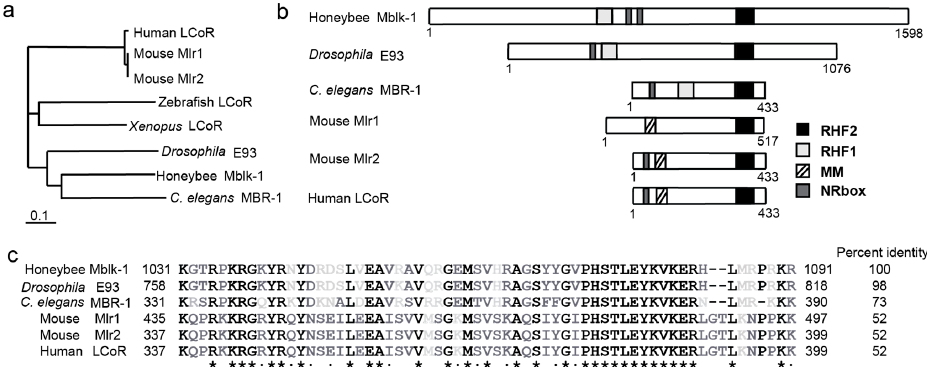
Figure 1. Mblk-1 family proteins are conserved among animals. ( a ) A phylogenetic tree of Mblk-1 family proteins. Generated by ClustalX2 using the neighbor-joining method; ( b ) Structures of Mblk-1 family proteins. RHF1, RHF2: helix-turn-helix DNA binding motifs. MM: mammalian Mlr motif; NR box: nuclear receptor binding motif. Adapted with permission from [23]; ( c ) Amino acid sequence alignment and the percent identities of the conserved RHF2 motifs from Mblk-1 family proteins. * Indicates a fully conserved residue; : indicates conservation between amino acids with strongly similar properties. Generated using Clustal Omega [24].